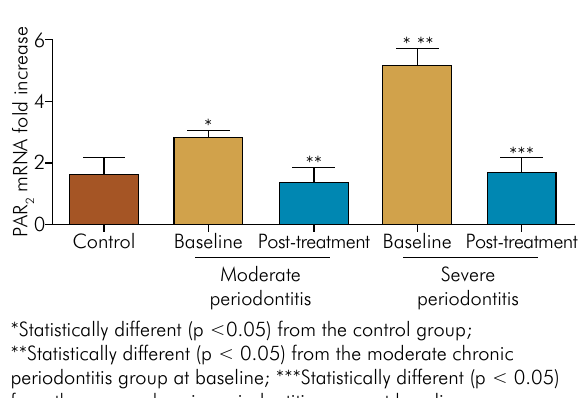
Figure 2. Mean and standard deviation of gingipain mRNA in the GCF of the control group and groups with chronic periodontitis at baseline and after non-surgical periodontal